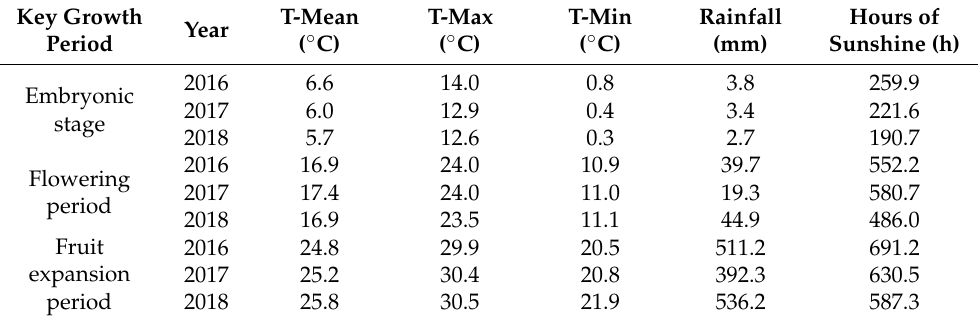
Table 3. Climate change during the critical growth period of apples in 2016–2018 for Beiquan Village, Hebei, China. T-Mean Key Growth Year Period